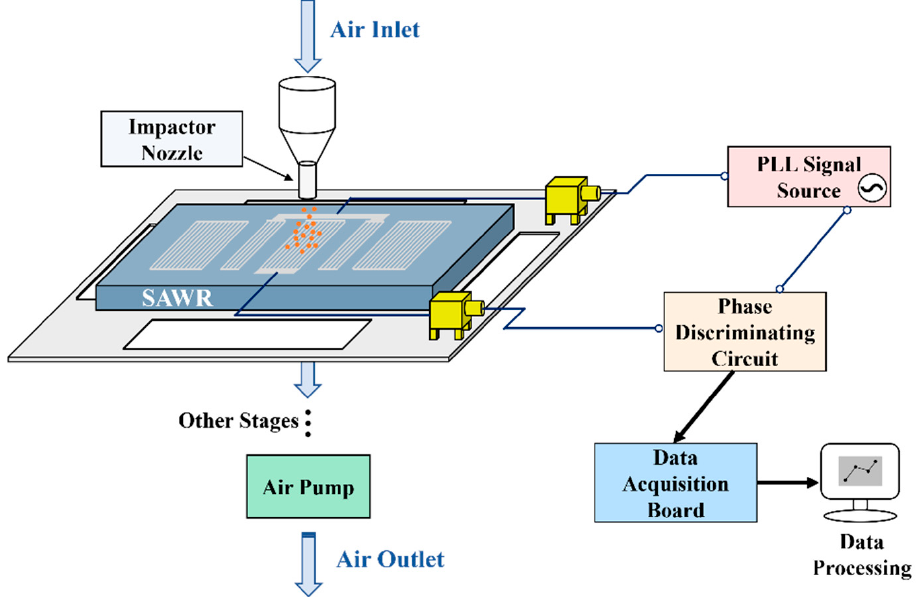
Figure 1. Schematic diagram of the multi-sized particles sensor based on the surface acoustic wave resonator and cascade impactor (single stage).